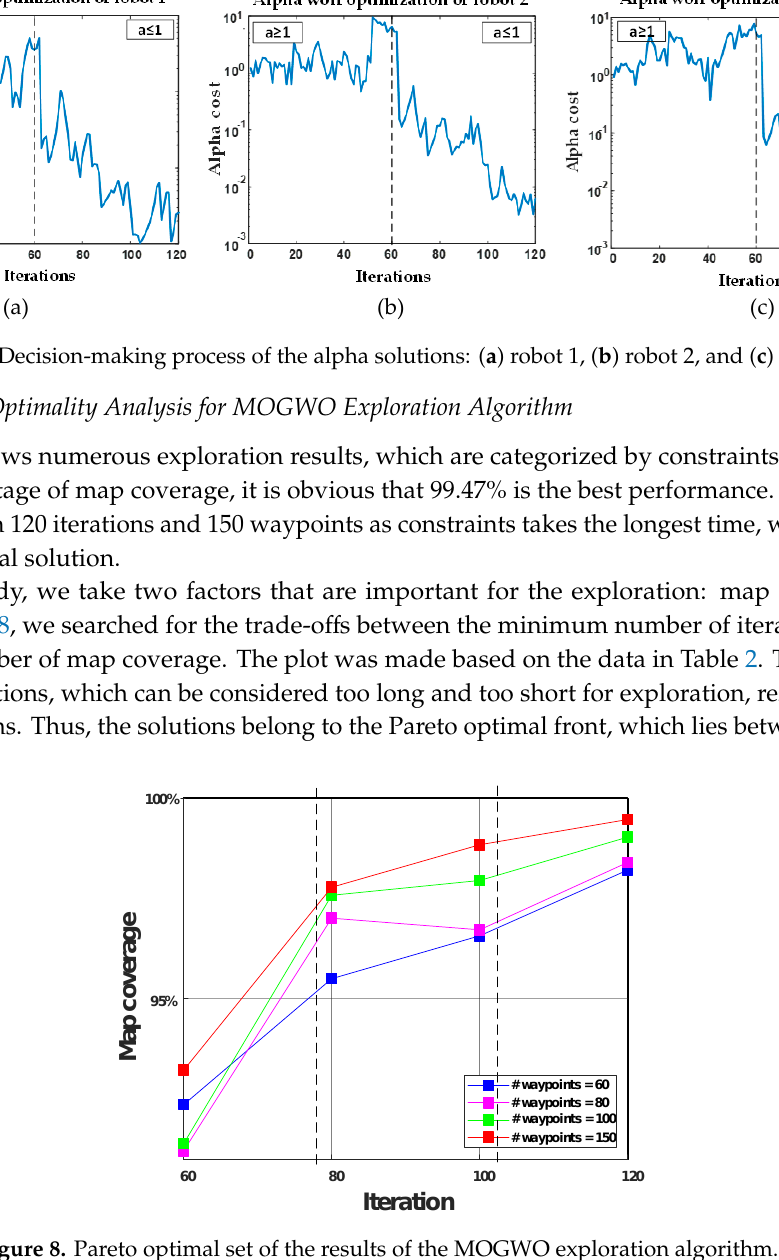
( d ) Figure 6. The simulation of MOGWO exploration algorithm in ( a ) iteration 1 with a = 2; ( b ) iteration 61 with a = 1; ( c ) the last iteration, 120, with a = 0.016; and ( d ) the trajectories of three robots.